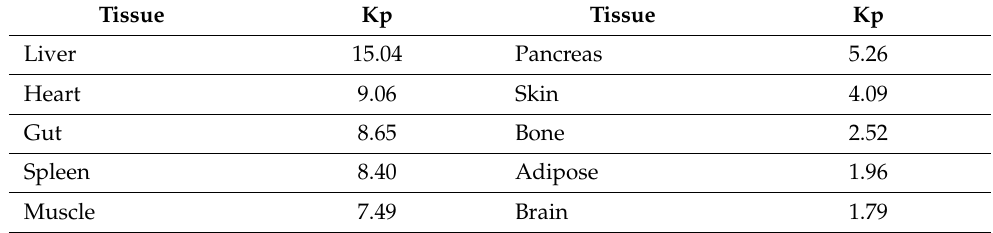
Table 4. LASSBio-1920 tissue partition coefficient (Kp) in human simulation module.